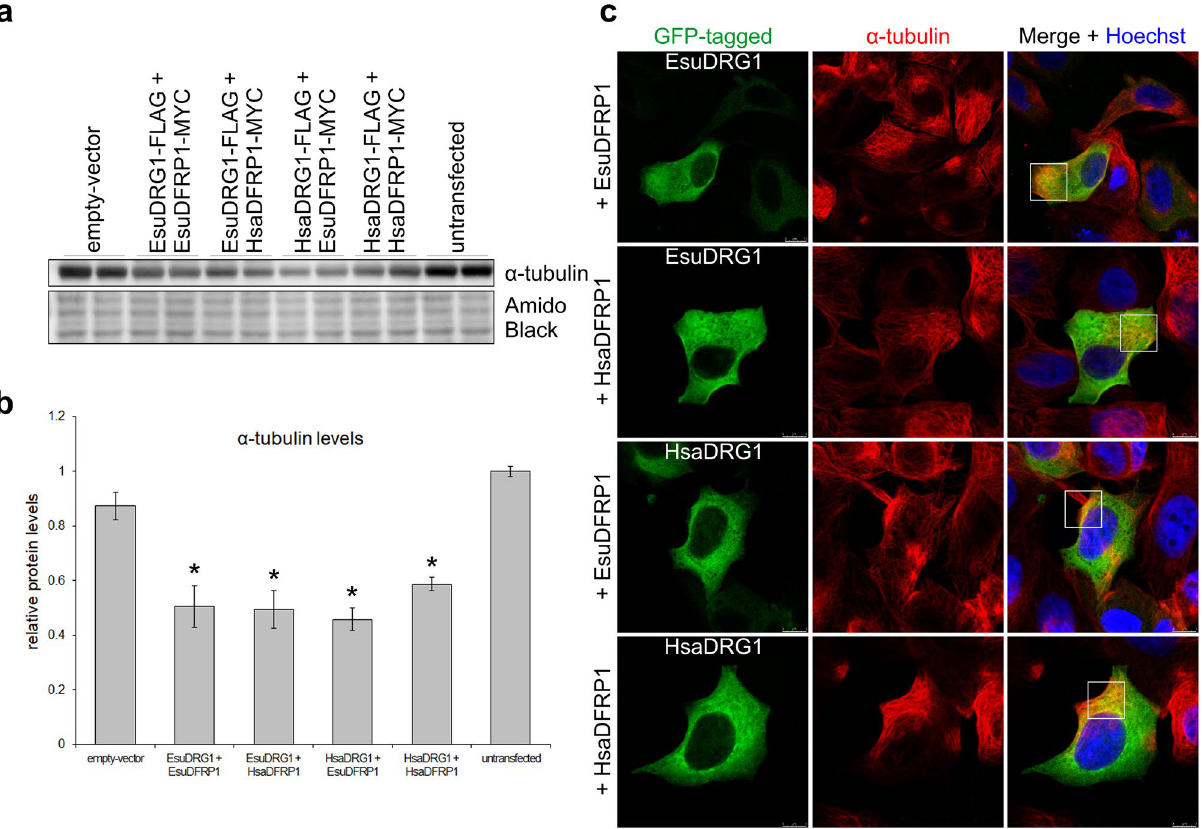
Figure 10. Sponge DRG1 co-localizes with α-tubulin and causes its decreased levels, similar to human DRG1. MCF-7 cells were co-transfected with human DRG1 or its sponge homolog (GFP-labelled) with human or sponge DFRP1 (not shown) and α-tubulin was detected with a specific antibody. ( a ) Western blot of α-tubulin levels. ( b ) Quantification of α-tubulin compared to empty-vector, * p < 0.05. ( c ) Colocalization (yellow square) of α-tubulin (red) with human and sponge DRG1-GFP (green). Hoechst was used to stain nuclei. The experiments were repeated three times in biological duplicates. Esu-sponge Eunapius subterraneus , Hsa-human. Original blots are presented in Supplementary Fig.